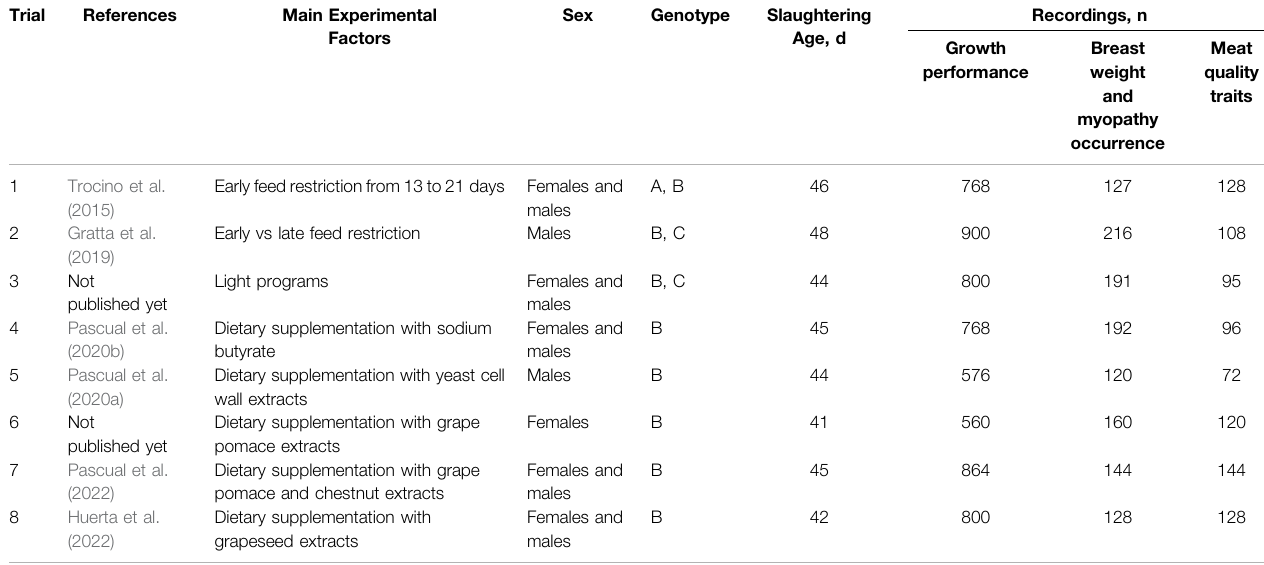
TABLE 1 | Summary of the main information about the eight experimental trials originating the